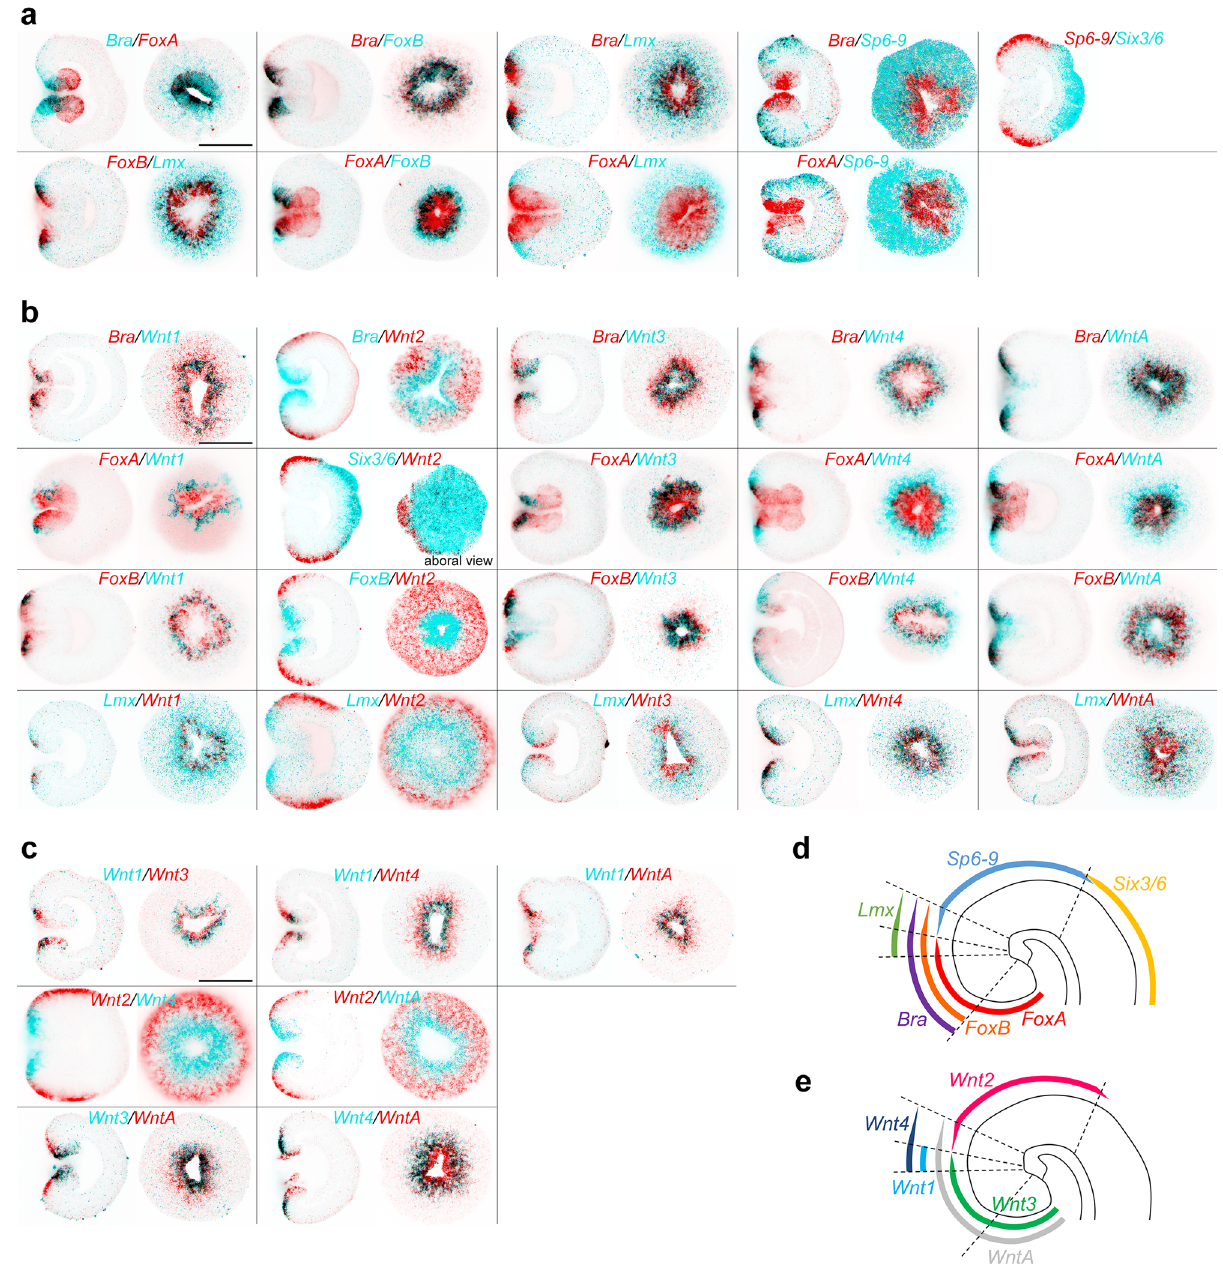
Fig. 2 Double FISH analysis of the expression domains of the four main repressor X candidates, oral Wnt genes, midbody markers Wnt2 and Sp6-9 , and aboral marker Six3/6 . a FISH analysis of the expression domains of the transcription factor genes Bra , FoxA , FoxB , Lmx , Sp6-9 and Six3/6 in relation to each other. b FISH analysis of the expression domains of the abovementioned transcription factor genes in relation to the expression domains of the ectodermally expressed Wnt genes. c FISH analysis of the expression domains of the ectodermally expressed Wnt genes in relation to each other. d Schematic representation of the expression boundaries of the transcription factors in the Nematostella gastrula. e Schematic representation of the expression boundaries of the Wnt genes in the Nematostella gastrula. On a – c , lateral views (oral to the left) and oral views (unless speci fi ed otherwise) of representative embryos from two independent experiments with n > 30 for each combination of in situ hybridization probes are shown. Scale bars 100 µ m. Dashed lines on d and e represent the same molecular